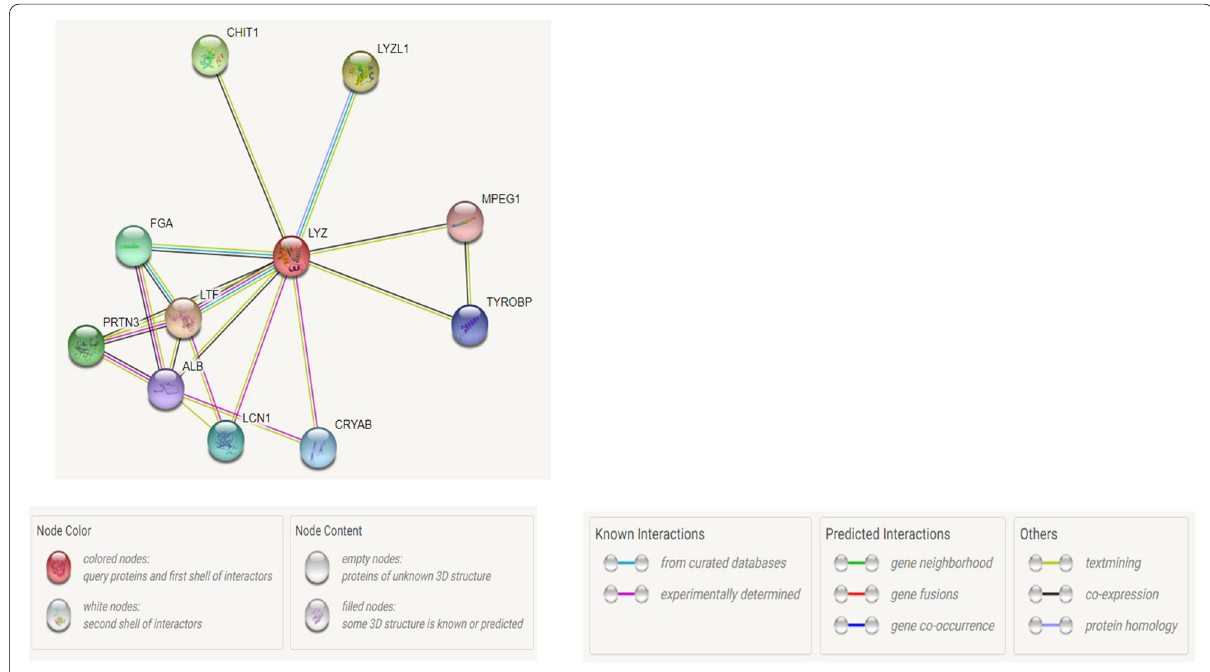
Fig. 2 Protein-protein interaction of LYZ C by STRING tool